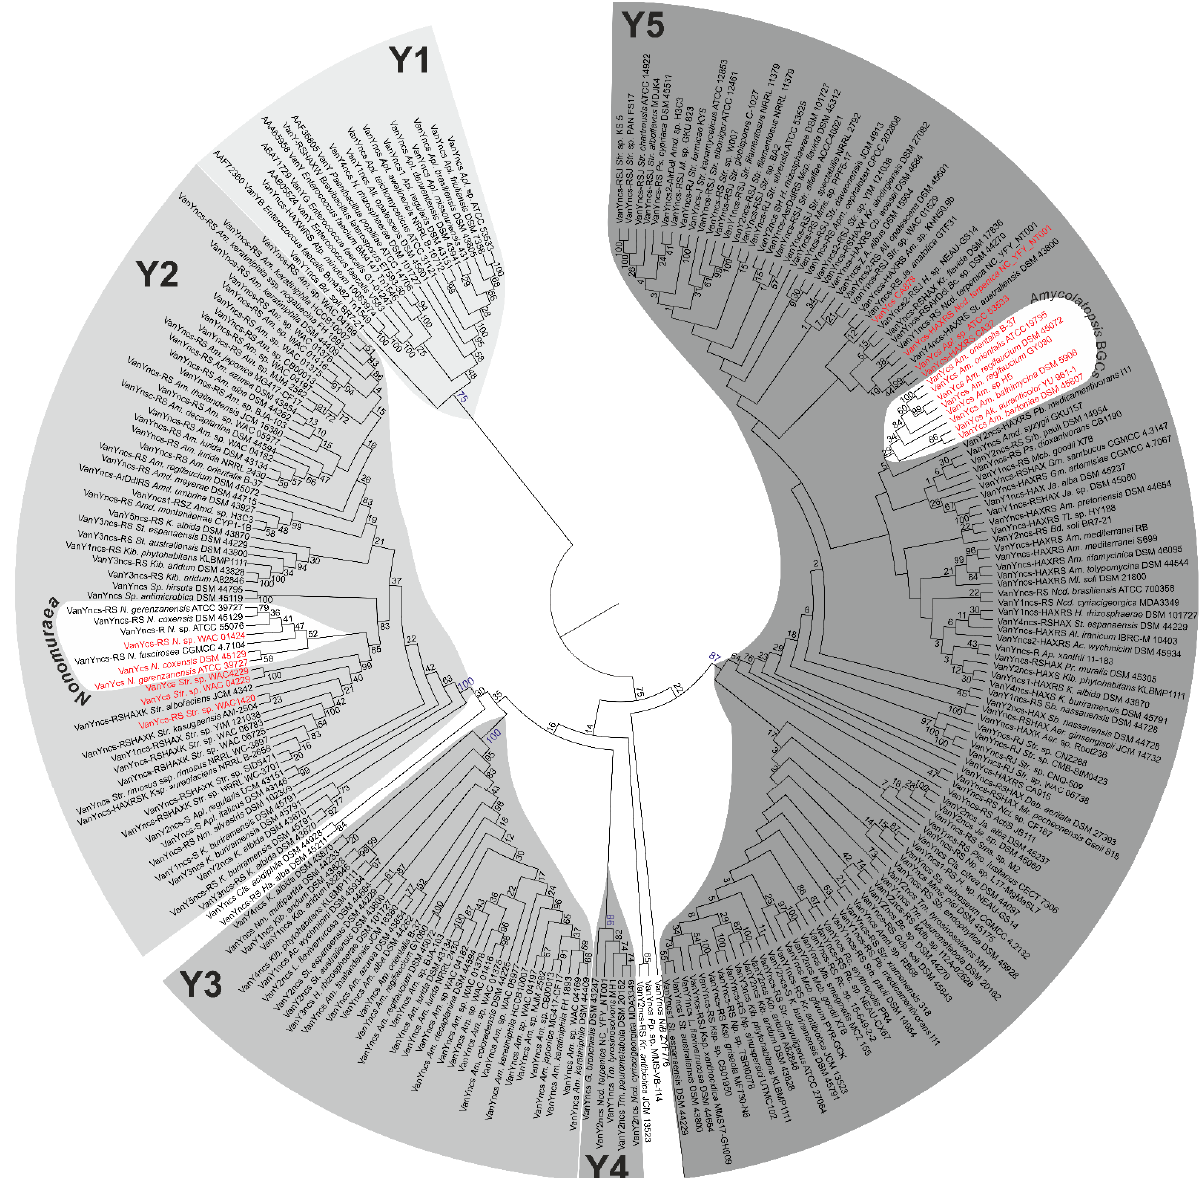
Figure 10. Maximum Likelihood phylogenetic tree of 251 VanY-like M15B carboxypeptidases. To show the topology of the tree better, branch lengths were ignored; the same tree drawn to scale is given in ESM Figures S3–S7. Five well supported clusters—Y1 to Y5—were distinguished on the tree. “cs/ncs” abbreviations in the label at the tip of each branch mean “cluster-situated/non-cluster-situated”. BGC-encoded proteins are given in red. Importantly, the most-studied VanY n (Dbv7) from the A40926-producing N. gerenzanensis ATCC 39727 [62] belongs to Y2, while VanY Ab (coming from the balhimycin producer Am. balhimycina DSM 5908 [63]) belongs to the Y5